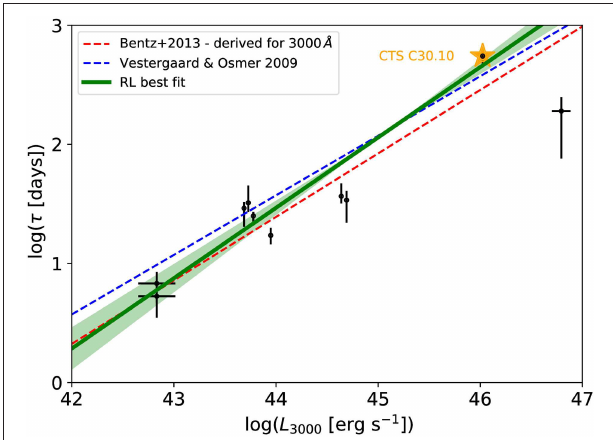
FIGURE 5 | The radius-luminosity relation for MgII broad line using the sources as listed in Table 3 in Czerny et al. (2019) and the new measurement of CTS C30.10 (orange star). The red dashed line stands for the standard L 5100 (Bentz et al., 2013), derived for 3,000 Å using the Bentz relation R H β − bolometric corrections from Netzer (2019): log( R BLR / 1lt-day) 1.391 = + 0.533log( L 3000 / 10 44 ergs − 1 ). The blue dashed line is the MgII-based radius-luminosity relation derived by Vestergaard and Osmer (2009): log( R BLR / 1lt-day) 1.572 0.5log( L 3000 / 10 44 ergs − 1 ). The green solid line is = + K the best-fit result using the general prescription log( R BLR / 1lt-day) = + α log( λ L λ / 10 44 ergs − 1 ) with K 1.47 0.06 and α 0.59 0.06. The = ± = ± shaded region corresponds to 1 σ uncertainties.